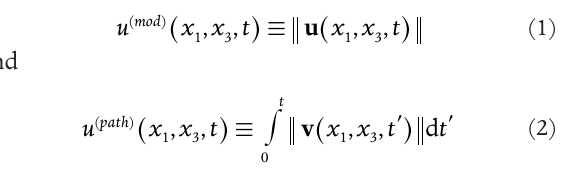
m 1 + - n 1 = and { . u v